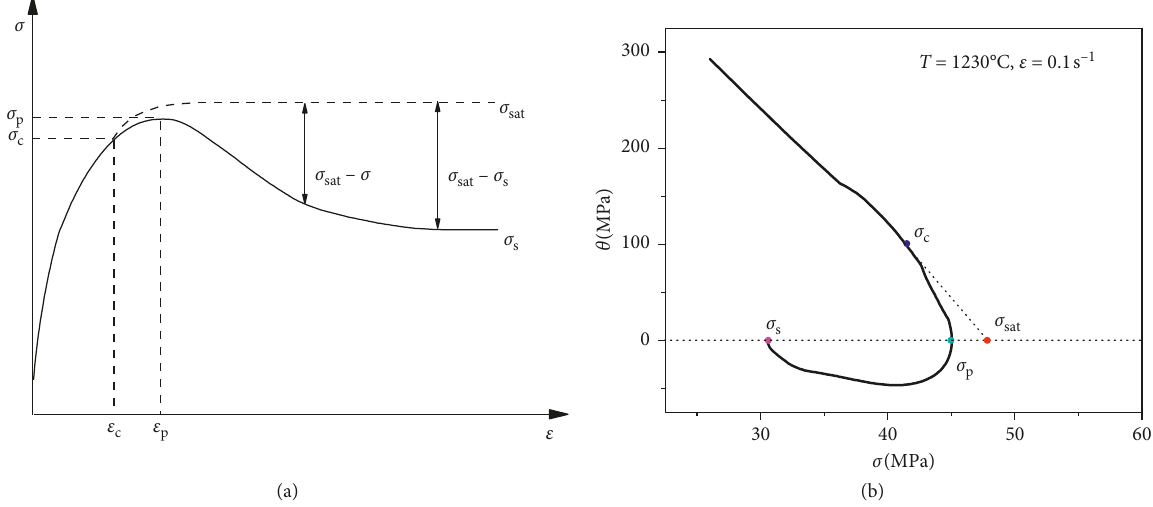
, σ , σ , and σ . c sat p s